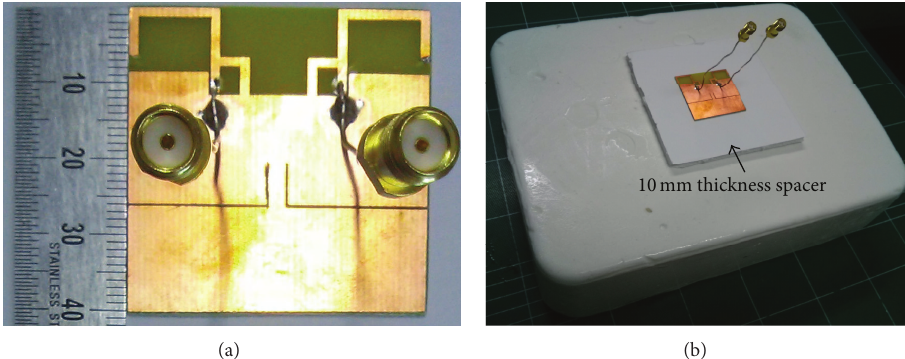
Figure 11: Fabricated antenna and phantom for measurement setup. (a) Fabricated antenna and (b) the antenna on the phantom for measurement setup.